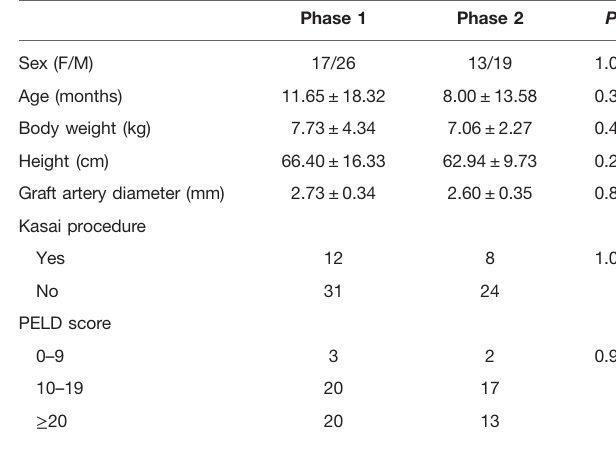
TABLE 1 | Overall patients characteristics ( n = 75). TABLE 2 | Patients ’ characteristics according to phases of the learning curve.